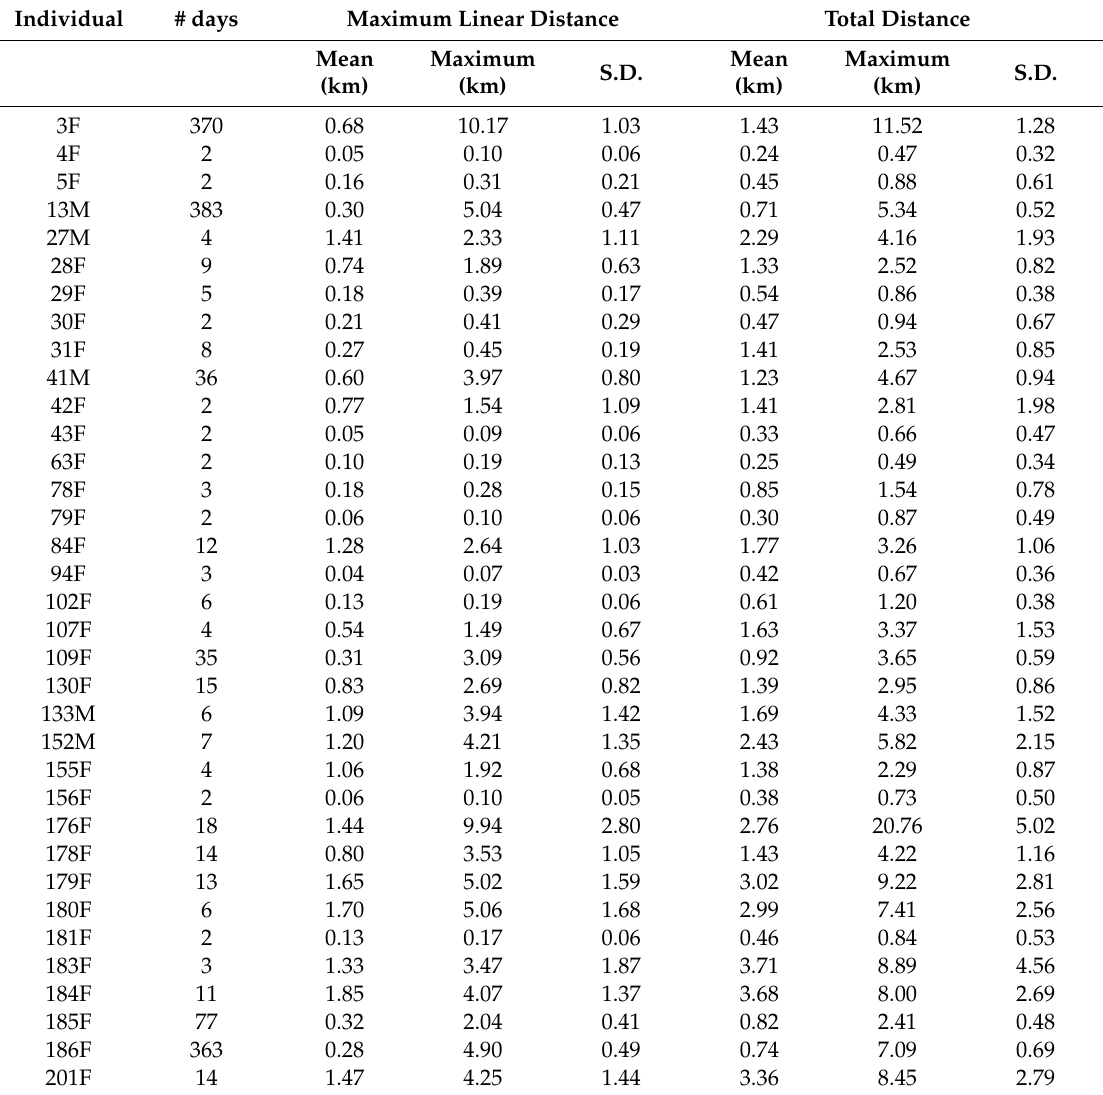
Table A1. Average daily maximum linear distance and average total daily distance moved by each GPS collared relocated western grey kangaroo (#: total number of days